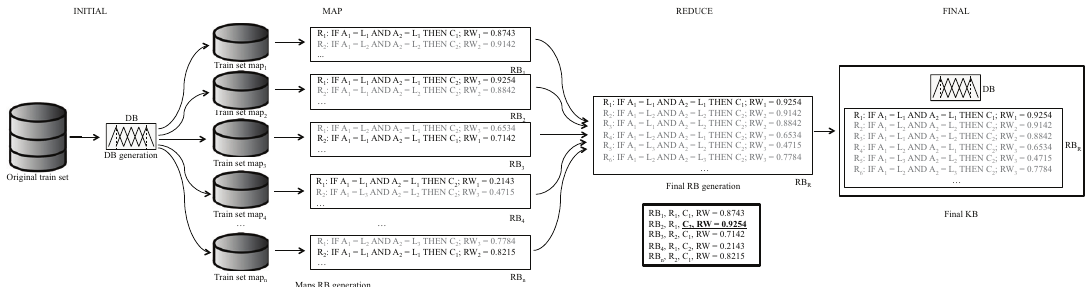
Train set map 1